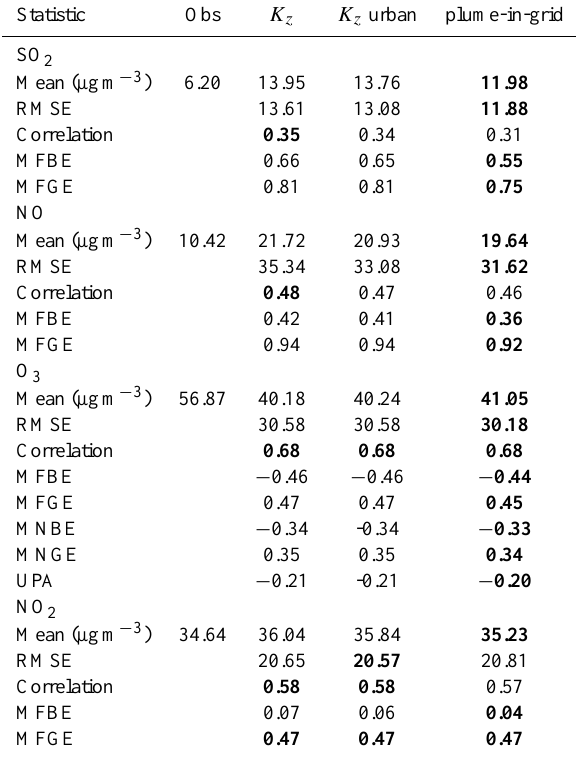
Table 2. Hourly statistics: comparison between (1) the simulation with the Eulerian model and a uniform minimal value for K z min , (2) the reference simulation, that is, the Eulerian model with a specific value for K z min in urban areas, and (3) the plume-in-grid results with similarity theory. The simulation period is 2001-04-01–2001- 09-27. The best statistics are highlighted in